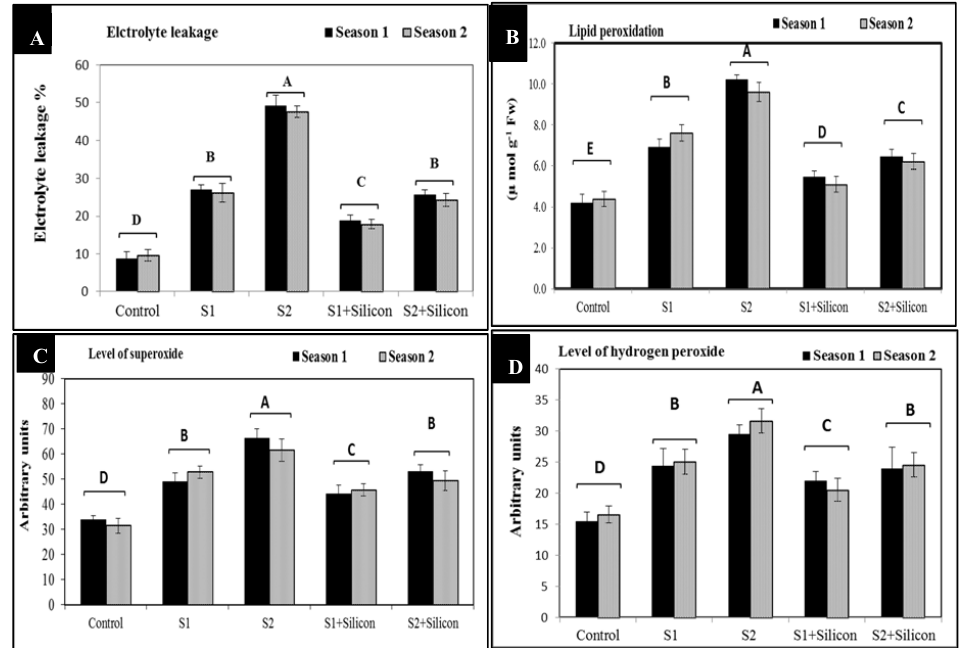
Figure 2. Effects of silicon on electrolyte leakage (EL %) ( A ), lipid peroxidation (MDA) ( B ), levels of superoxide ( C ) and hydrogen peroxide ( D ) in salt-stressed sweet pepper plants in the 2018 and 2019 seasons. S1: Salinity at 1500 ppm, S2: Salinity at 3000 ppm.